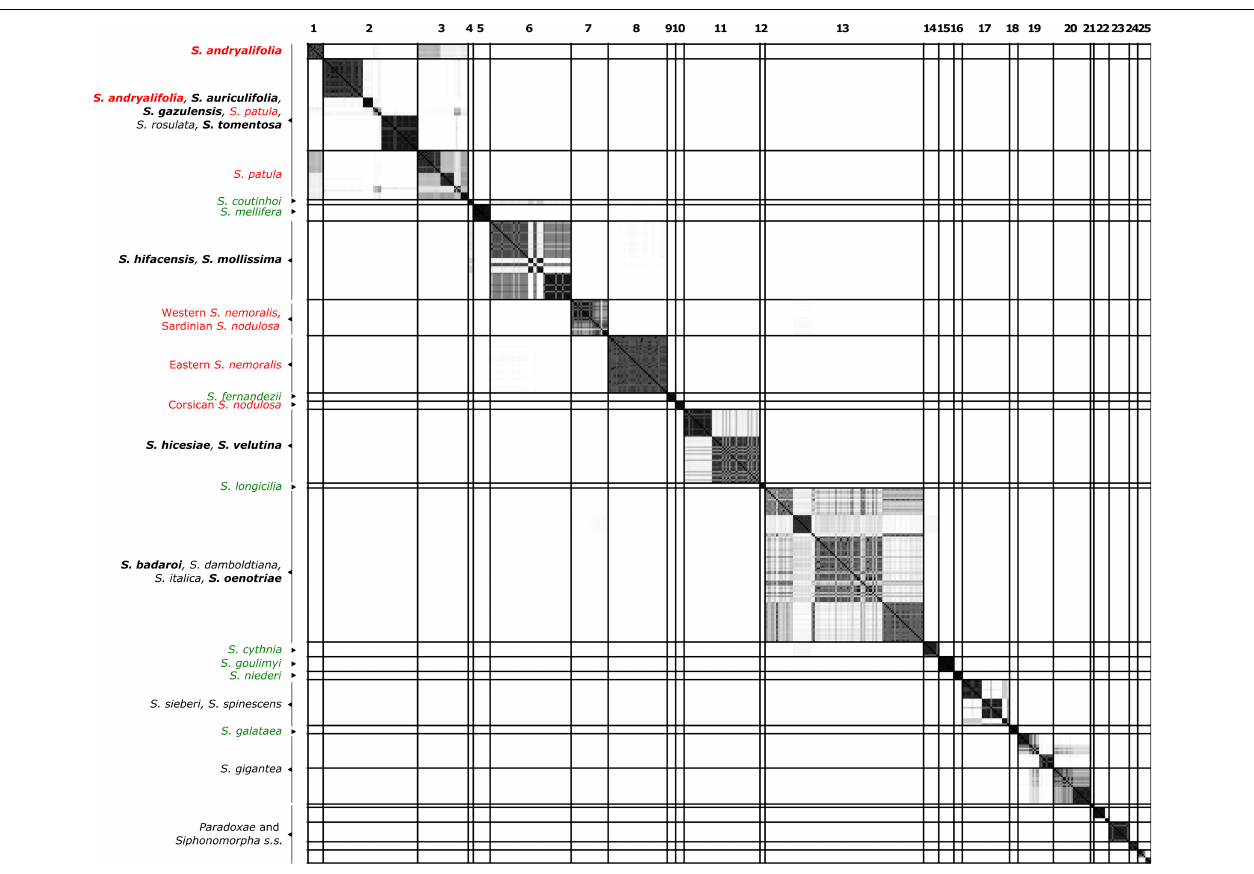
FIGURE 2 | Similarity matrix showing the posterior probability that two individuals belong to the same Multi-Species Coalescent cluster (MSCC) according to the species tree of Figure 1 . A black square indicates a posterior probability of 1, while no color indicates a posterior probability of 0. Specimens are given in the same order as in Figure 1 . The lines delimit 26 clusters that are comprised of individuals with pairwise posterior probabilities higher than 0.01. Species found in different clusters are indicated in red, while well-delimited species are colored in green. Species in black are those found with at least one additional species in the same clade. The chasmophytic species are indicated in bold. Here, Sect. Paradoxae includes S. paradoxa , S. confertiflora , S. fruticosa and S. aristidis and Sect. Syphonomorpha s.s. includes S. nutans and S. viridiflora .